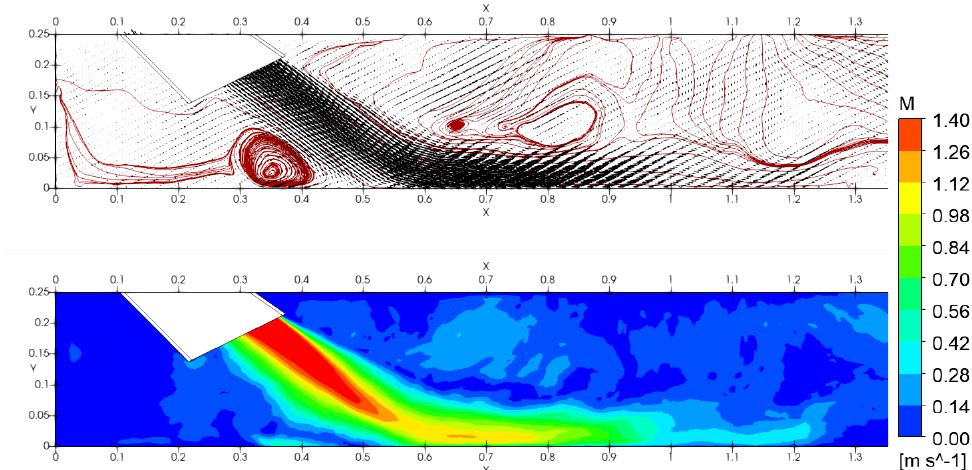
Figure 8. LBM, vector lines ( top ) and the magnitude of time-averaged 2D velocity ( bottom ) in vertical plane ( z = 0mm ) .